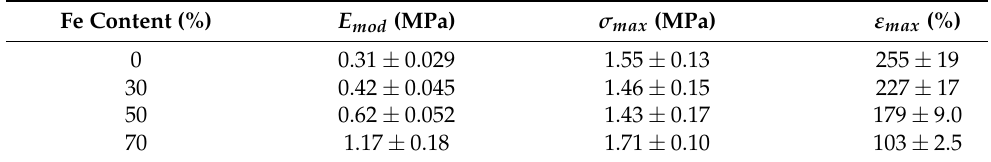
Figure 9. The force measurement between soft beam and permanent magnet. The force sensor for sample 1 ( a ) and sample 2 ( b ). The representation of force as a function of the position for sample 1 ( c ) and sample 2 ( d ). Table 5. The results of the mechanical strength measurements (Young modulus E mod , tensile strength σ max and elongation at break ε max ) for magnetorheological elastomers with various iron powder